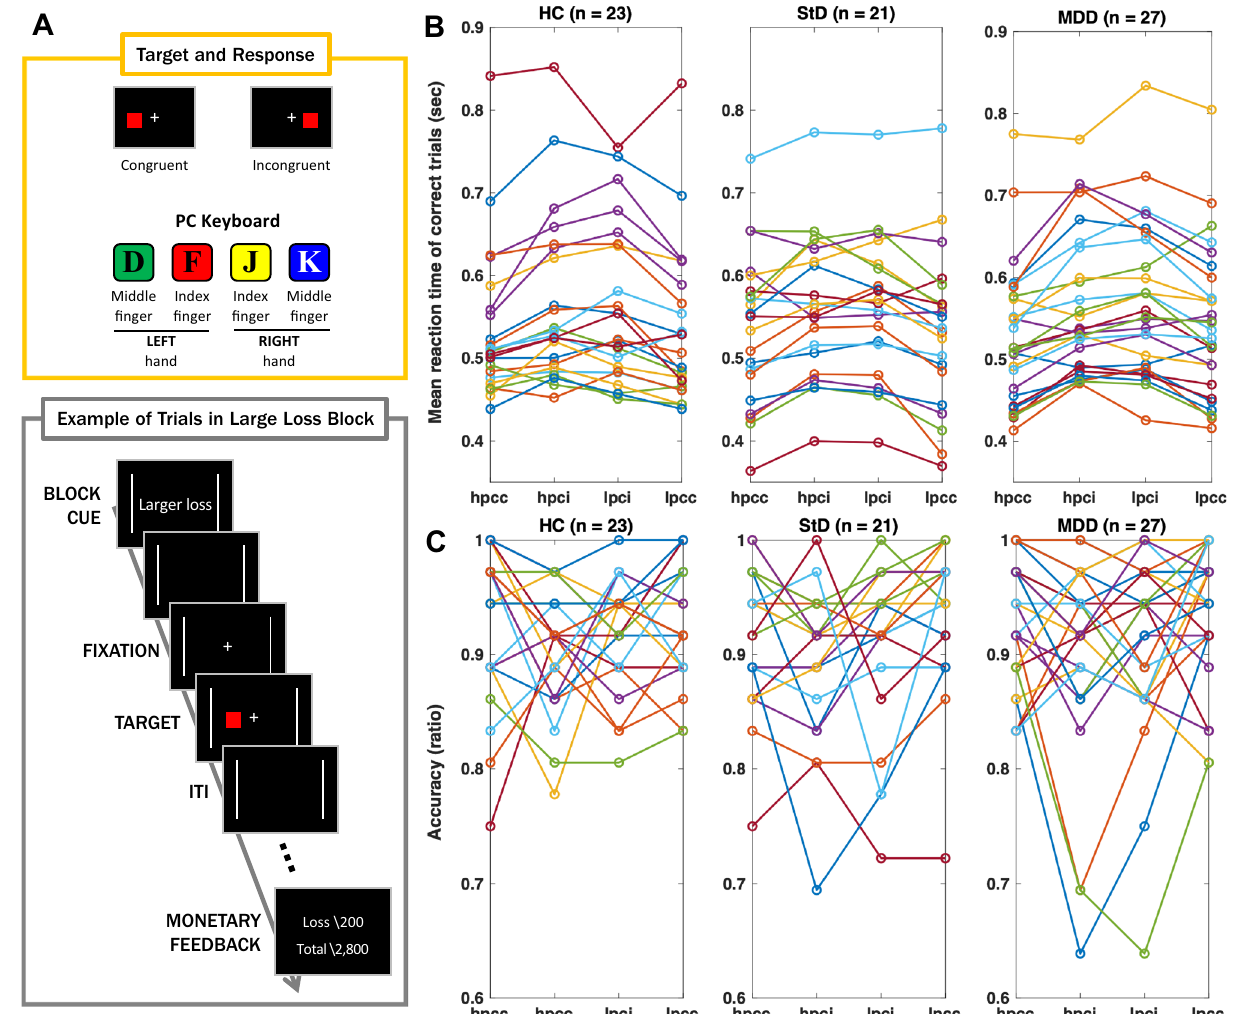
Figure 1. Conflict control against larger or smaller monetary punishment (per error response). ( A ) Task diagram. ( B ) Spaghetti plot of mean reaction times averaged for correct trials per participant (sec). A statistically significant simple two-way interaction between the size of monetary loss versus congruency was found in MDD [F (1, 23) = 4.489, P = 0.045] but not in the HC (P = 0.674) or StD (P = 0.645). For the simple main effects, statistical significance was found for the (in)congruence of target-response location [F (1, 58) = 58.655, P < 0.001) but not for the size of monetary loss (P = 0.653) nor diagnosis (P = 0.649). ( C ) Spaghetti plots of accuracy ratio. Statistically significant simple two-way interactions between the size of monetary loss and congruency were not observed in MDD (P = 0.617), StD (P = 0.294), and HC (P = 0.760). Regarding main effects, statistical significance was found for conflict in target-response location [F (1, 58) = 11.548, P = 0.001] but not for the size of monetary loss (P = 0.068) or diagnosis (P = 0.534). HC healthy controls, StD subthreshold depression, MDD major depressive disorder, hpci incongruent trial against larger monetary loss, hpcc congruent trial against larger monetary loss, lpci incongruent trial against smaller monetary loss, lpcc congruent trial against smaller monetary